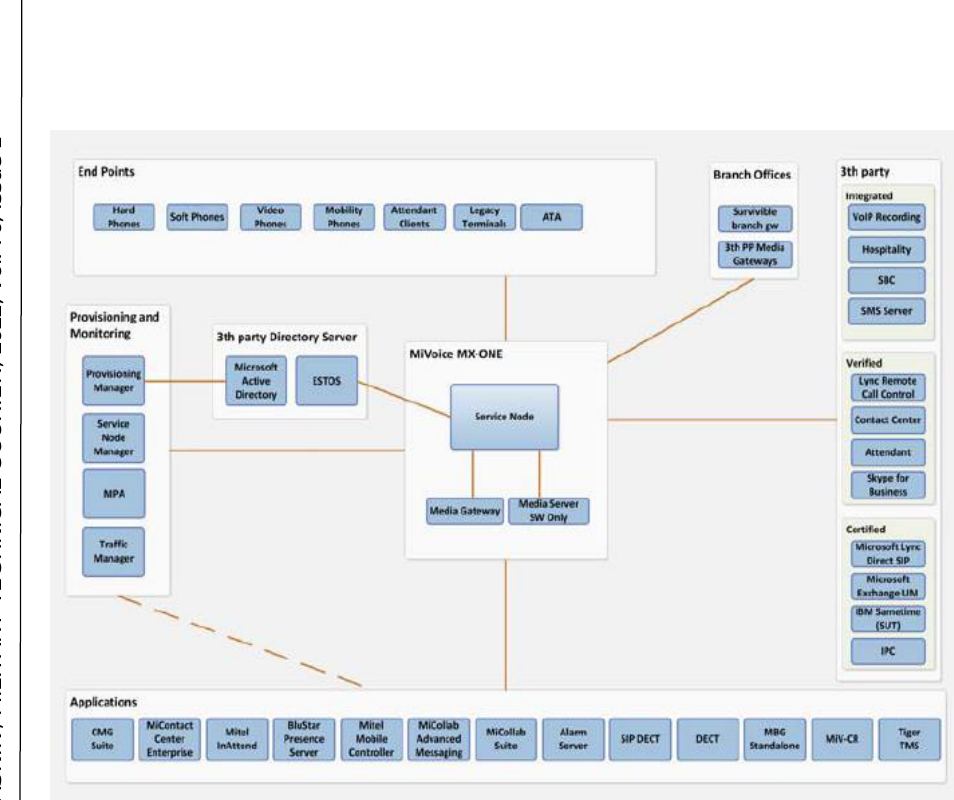
Figure 1 – Overview of the main and additional components, devices and applications of the IP-oriented PINX type MX-ONE Service Node 6.0 (Mitel Sweden AB,